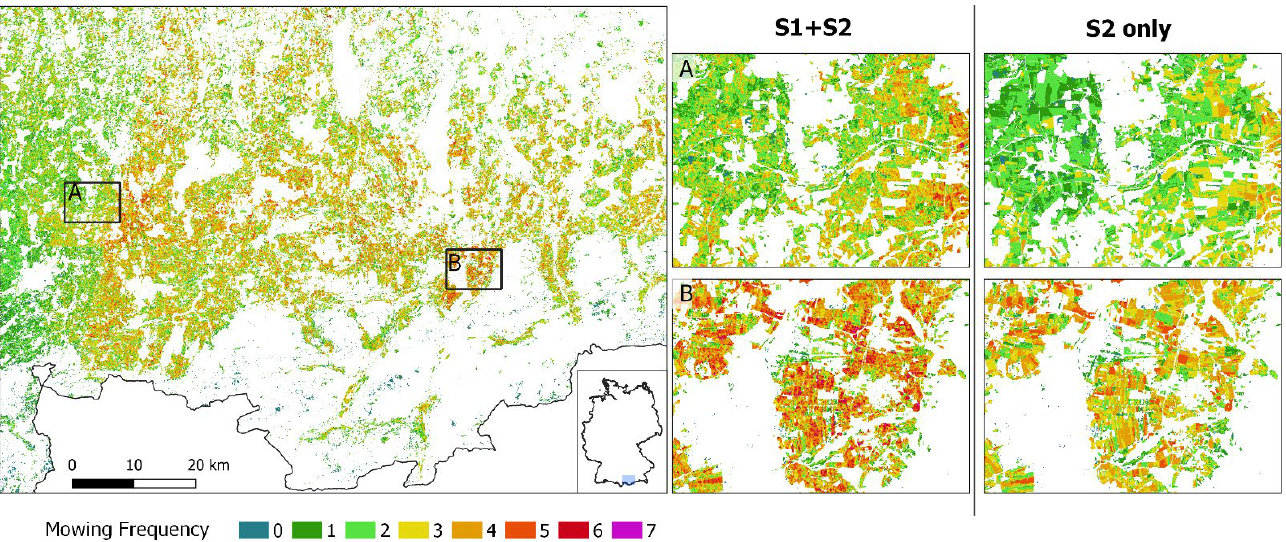
Figure 6. Detected mowing frequency of grassland reference parcels within the focus region when using S2 only and the combined approach consisting of S1 and S2, compared to the true condition.